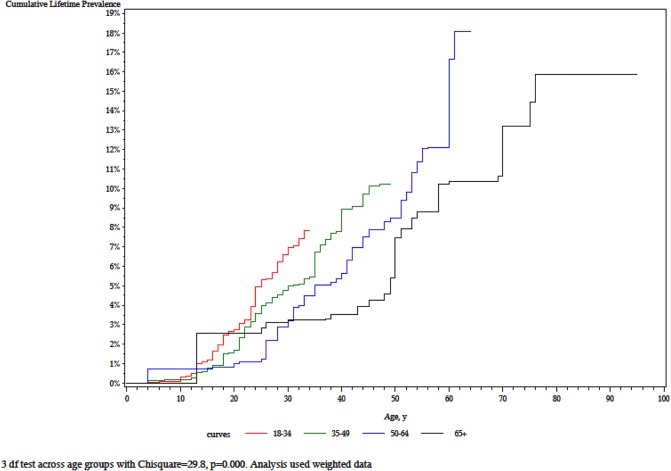
Cumulative lifetime prevalence of DSM-IV major depressive by birth cohort in Iraq.